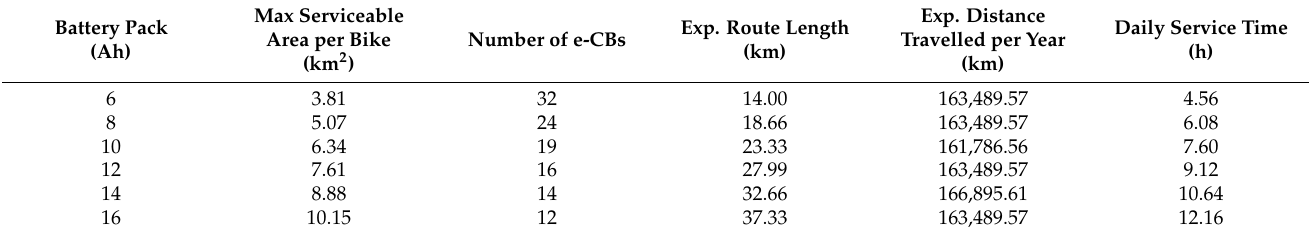
Table 4. Design alternatives.